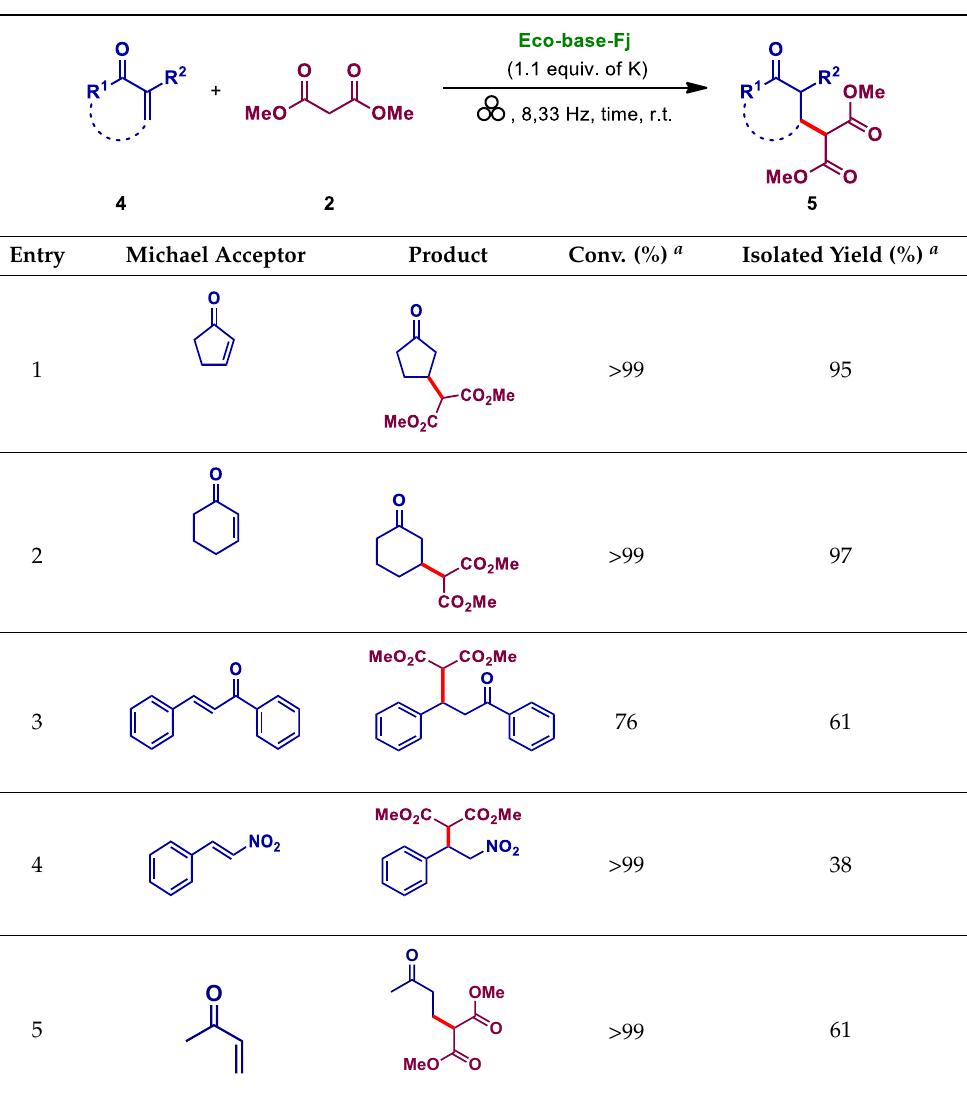
Table 6. Variation of Michael Table 6. Variation of Michael acceptors. Table 6. Variation of Michael acceptors. Table 6. Variation of Michael acceptors. Table 6. Variation of Michael acceptors. Table 6. Variation of Michael acceptors. Table 6. Variation of Michael acceptors. Table 6. Variation of Michael acceptors. Table 6. Variation of Michael acceptors. Table 6. Variation of Michael acceptors. Table 6. Variation of Michael acceptors.